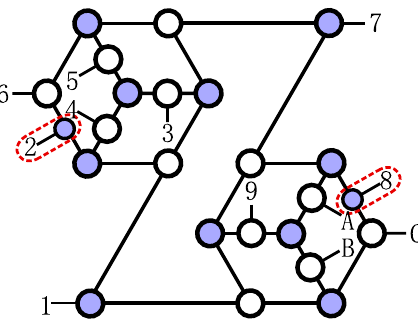
Fig. 5 An N 4 MHV example with two auxiliary